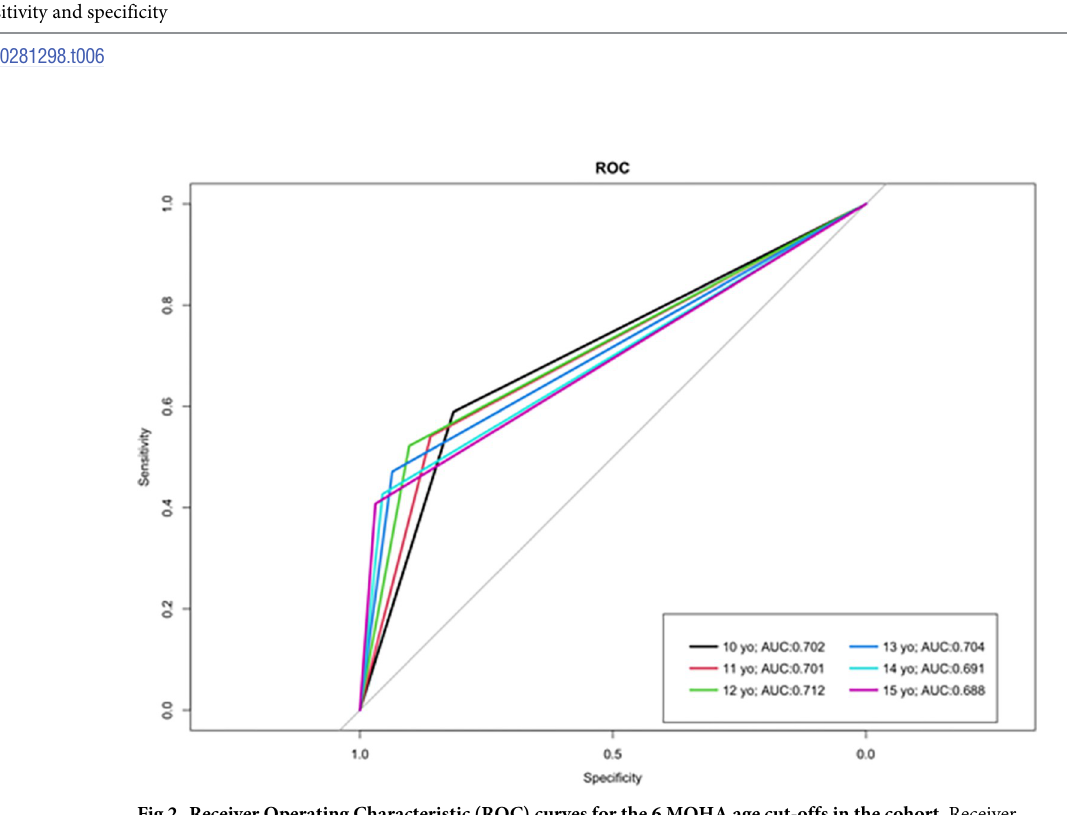
Fig 2. Receiver Operating Characteristic (ROC) curves for the 6 MOHA age cut-offs in the cohort. Receiver Operating Characteristic (ROC) Curves for the 6 MOHA age cut-offs in the cohort with their respective area under the curve (AUC)